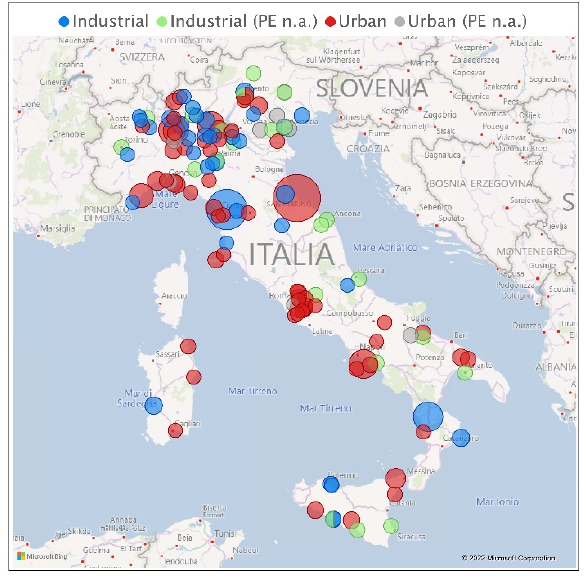
Figure 1. Location of MBR plants in Italy (the area of the circles is proportional to PE-if available) n.a.: not available.